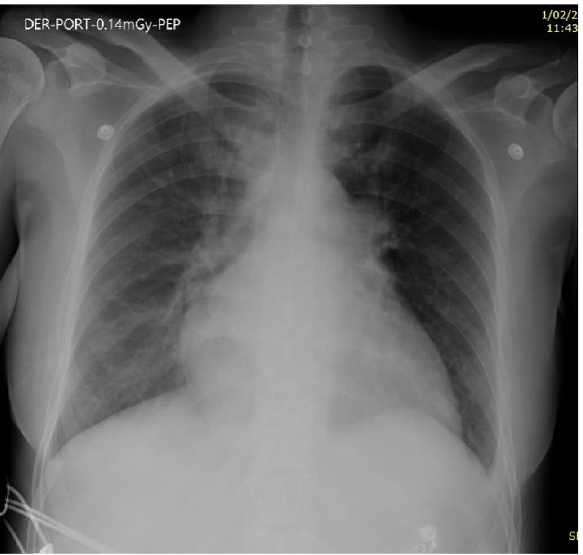
Figure 1 : Chest X-ray shows enlargement of the cardiac silhouette and bilateral interstitial